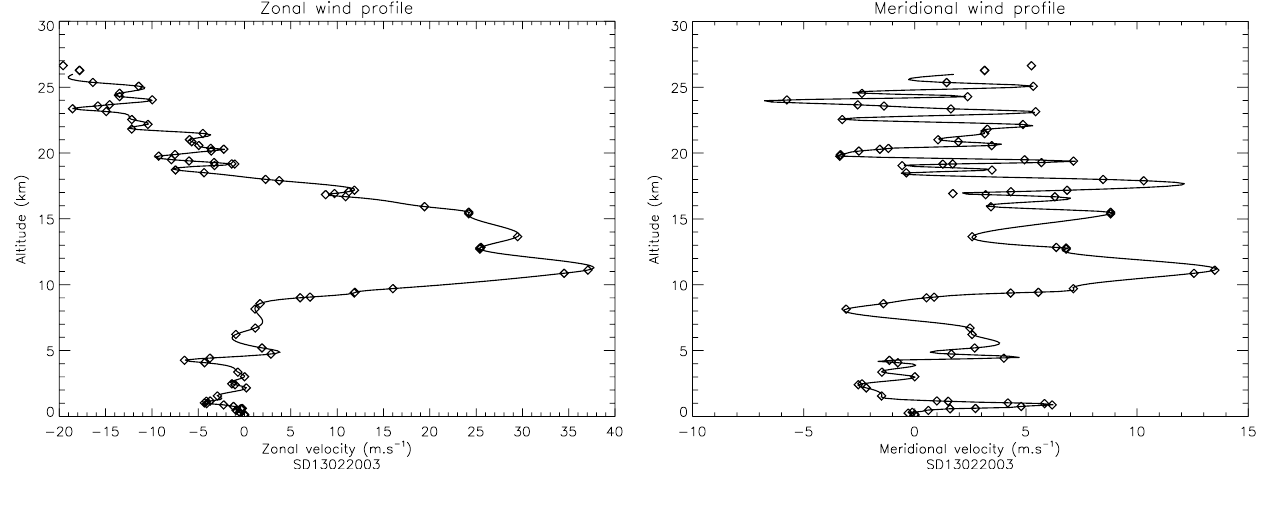
Fig. 1. Case 1: Santo Domingo radiosounding. Vertical profile of the wind velocity (ms − 1 ). Diamonds correspond to sounding mea- surements. Full line is a cubic spline interpolation with vertical resolution of 100m. Left: Zonal wind profile. Right: Meridional wind profile.